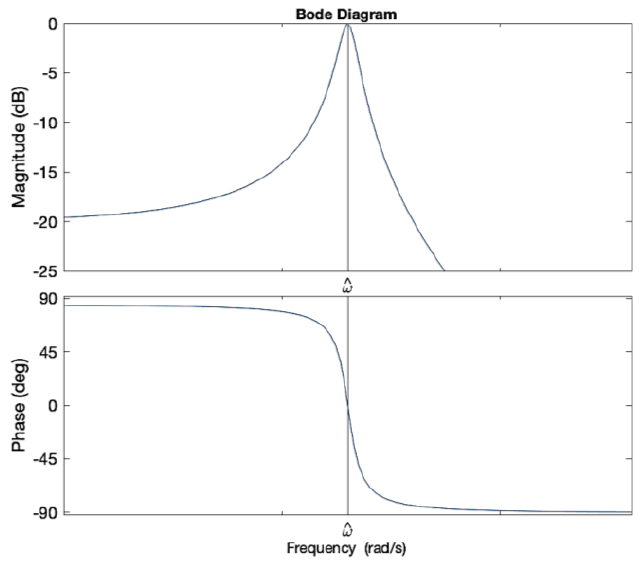
Figure 8. Magnitude and phase Bode diagram of the FACCF.